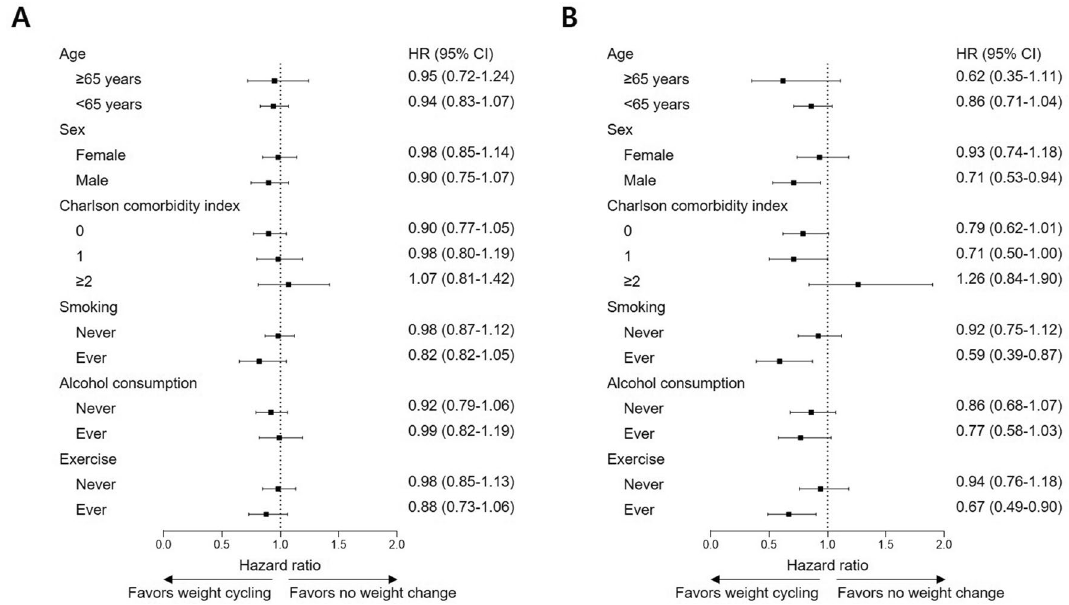
Figure 2. Subgroup analyses on cardiovascular risks of weight cycling compared to no weight change. ( A ) Cardiovascular disease. ( B ) Coronary heart disease.